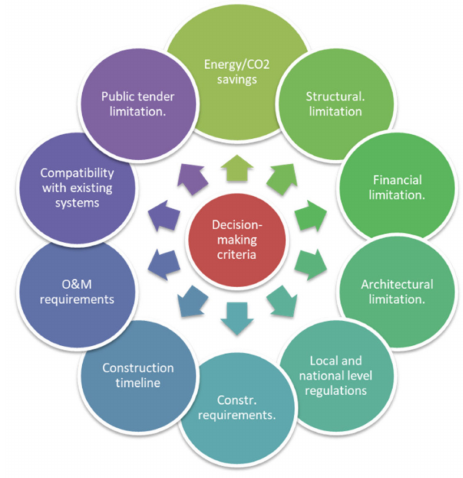
Figure 2. Decision-making criteria. Table 2. Decision-making